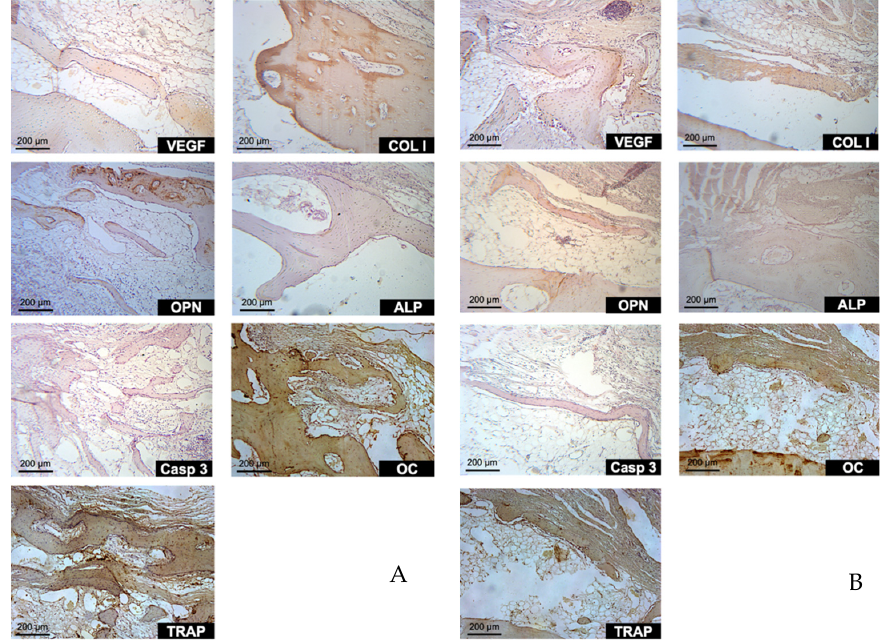
Figure 12. Autogenous ( A ) and xenogenous ( B ) groups after 60 days. Immunolabeled proteins used in this study: VEGF: vascular endothelial growth factor; COL I: collagen type I; OPN: osteopontin; ALP: alkaline phosphatase; Casp 3: caspase 3; OC: osteocalcin; TRAP: tartrate-resistant acid phosphatase. Magnification 200×. Table 3. Scores obtained for the immunolabeled proteins used in this study. 0: absence; 1: light; 1.5: light to moderate; 2: moderate; 2.5: moderate to intense; 3: intense.